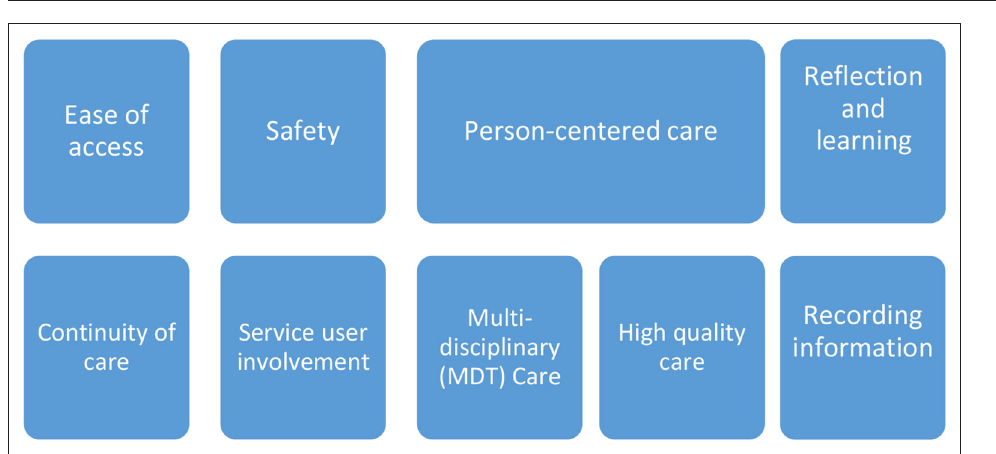
Figure 1 Faculty for Homeless and Inclusion Health key values for providing